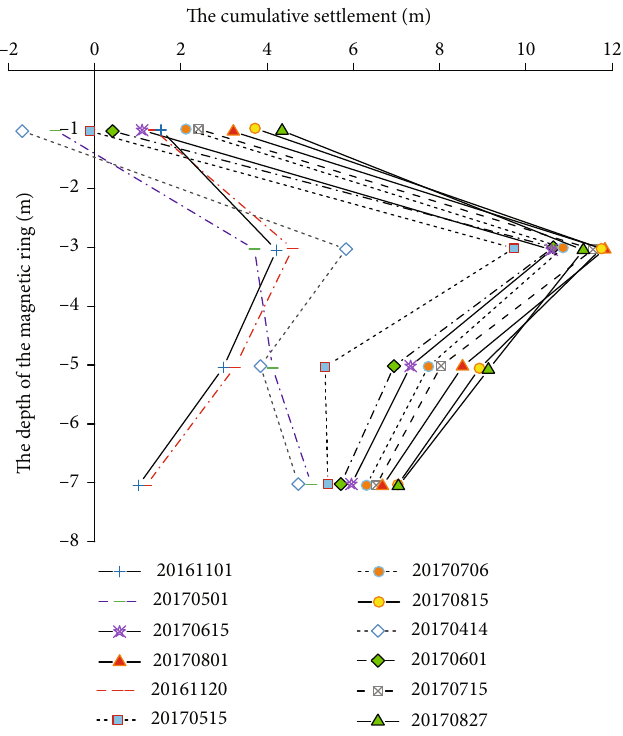
Figure 4: Typical curve of the layered settlement of the subgrade in the experimental section.